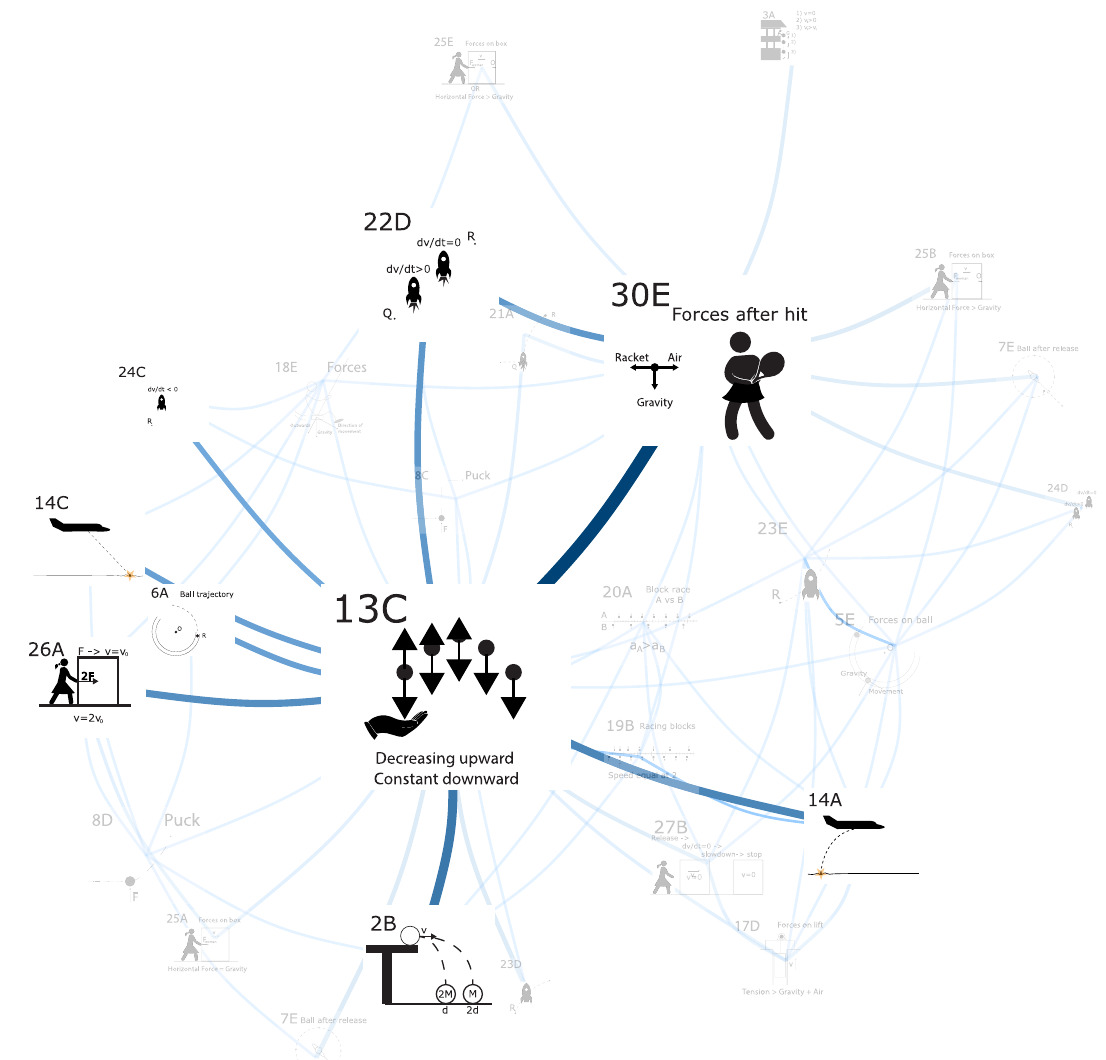
FIG. 9. Illustration of the impetus module using pictograms. Each pictrogram represents a response